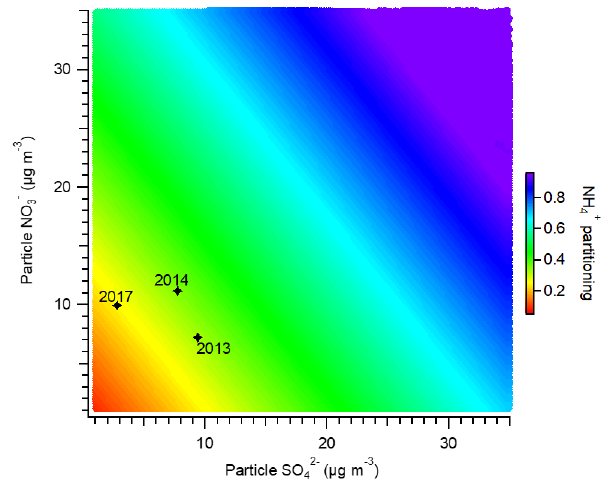
Figure 10. Sensitivity of the ammonium partitioning ratio to the mass concentrations of particulate sulfate and nitrate. The stars in- dicate the average winter conditions for the years 2013, 2014, and